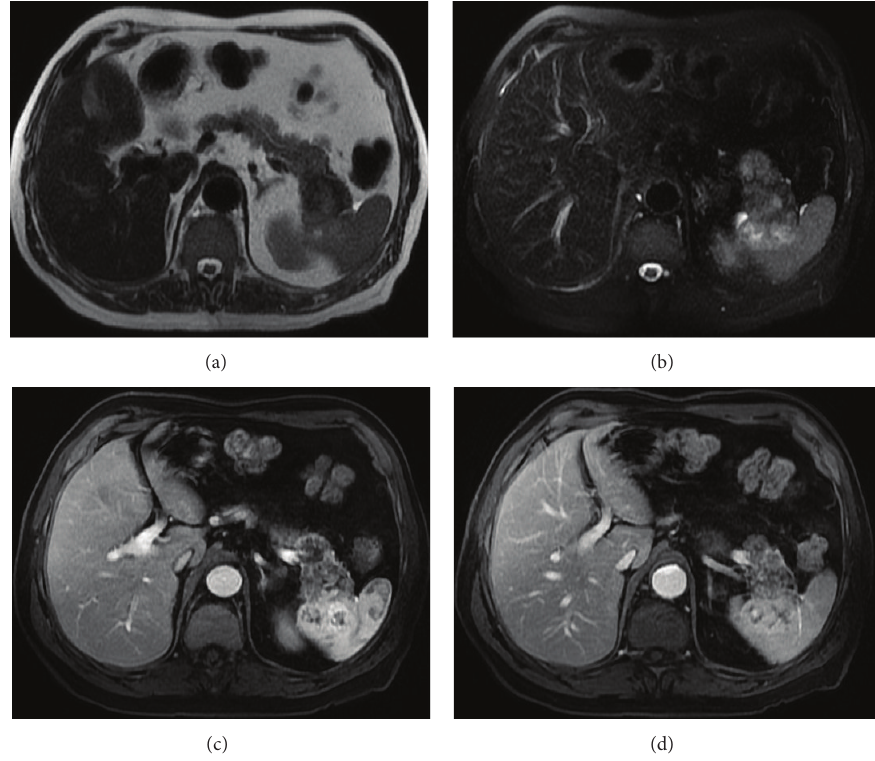
Figure 18: Pancreatic tail clear cell renal cell carcinoma metastases with infiltration of the spleen through the splenic hilum. Axial T2wi SSFSE without (a) and with (b) fat suppression and axial postcontrast T1wi 3D-GRE with fat suppression in the arterial (c) and venous (d) phase. A large heterogeneous mass is seen in the pancreatic tail infiltrating the